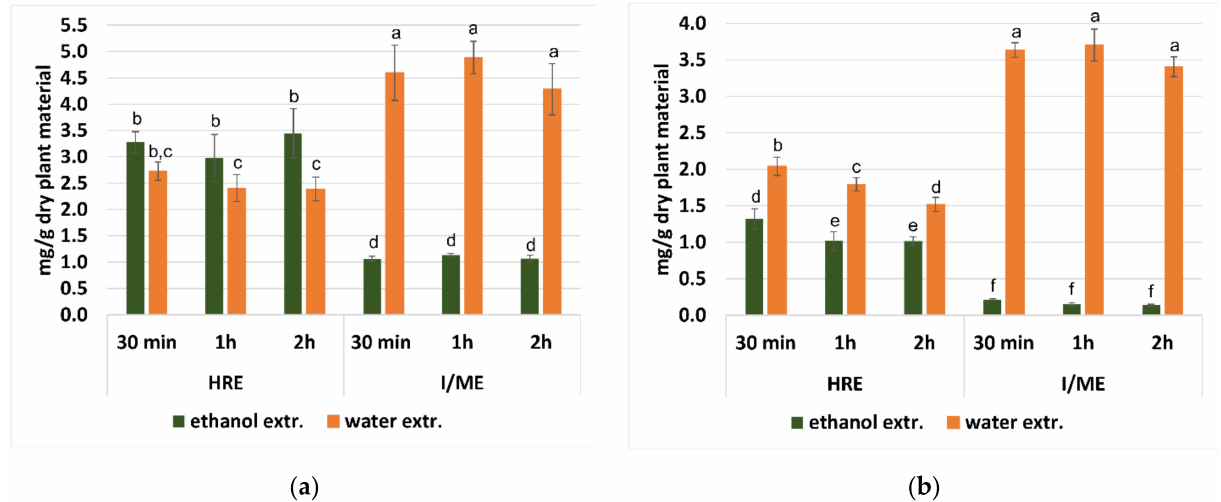
Figure 1. The content (mg/g dry plant material) of rosmarinic acid (RA) ( a ) and chlorogenic acid (ChA) ( b ) in water and ethanol extracts from dried aerial parts of G. hederacea L., prepared by pouring boiling solvent followed by maceration for 30 min, 1 h or 2 h at room temperature (I/ME) and heat reflux extraction (HRE). Results are presented as the mean ± SD (standard deviation) calculated from six independent experiments. The means with the same letter are not significantly different from each other ( p > 0.05, F Welch’s ANOVA, followed by Tukey’s multiple comparison test), within the samples